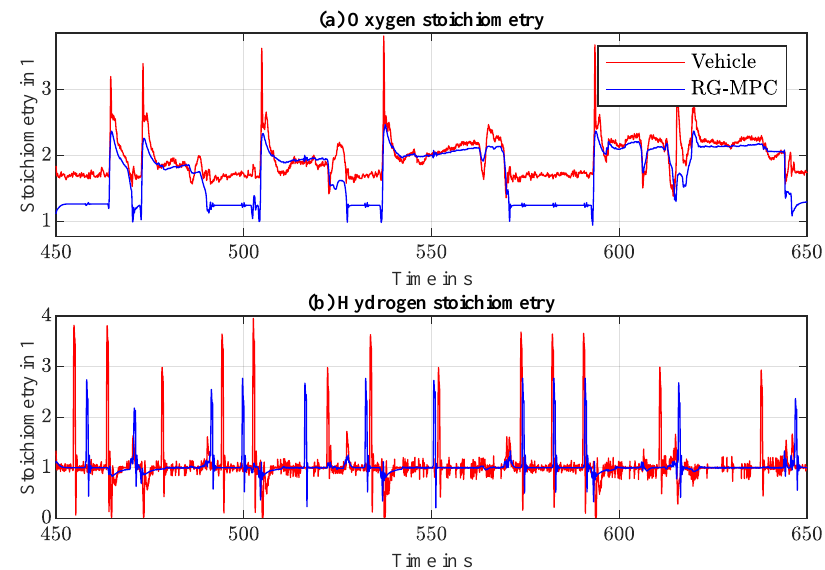
Figure 9. ( a ) Oxygen stoichiometry, ( b ) hydrogen stoichiometry.